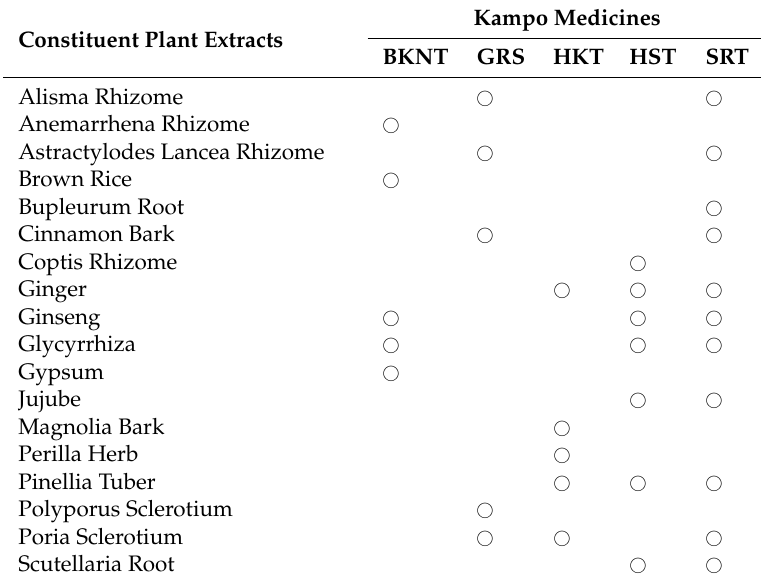
Table 1. Kampo medicines and their constituent plant extracts used for treatment of stomatitis in the